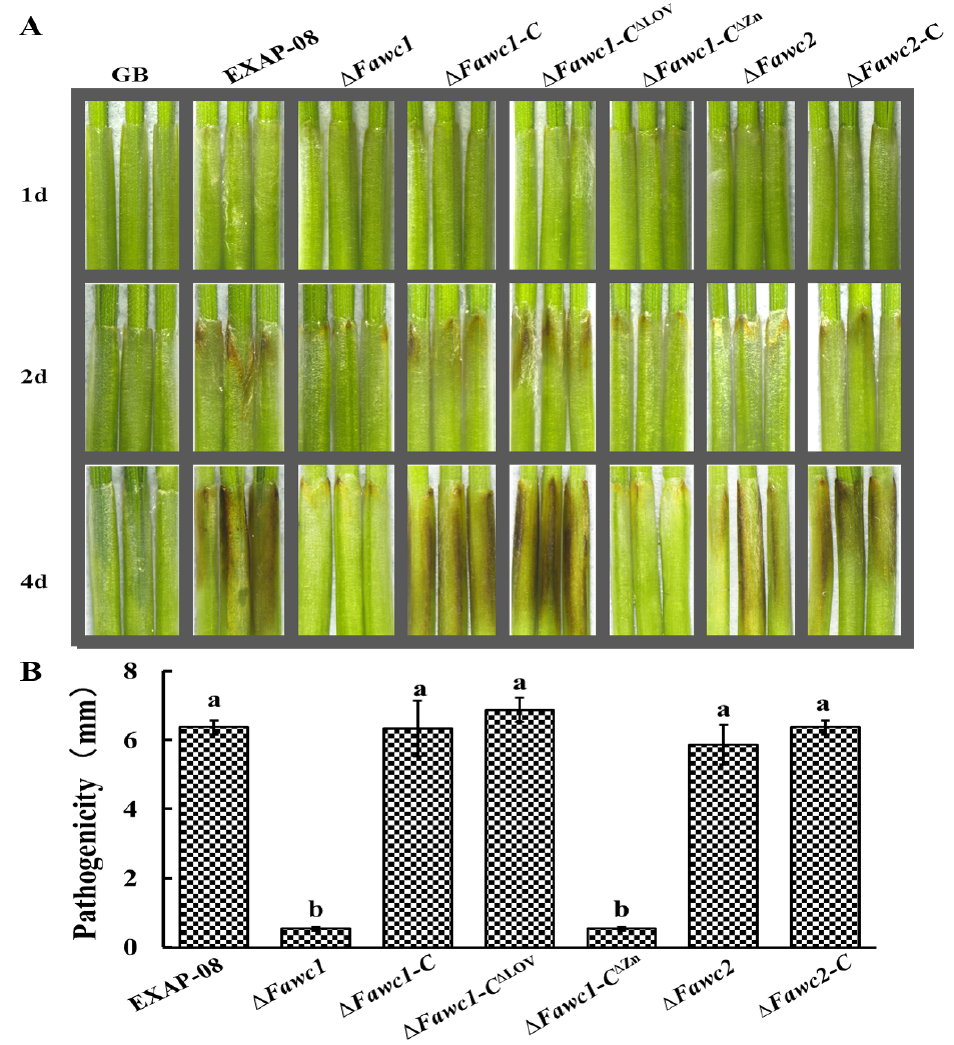
Figure 6. Virulence assay on wheat confirms that Fawc1 regulate the virulence of F. asiaticum in a light-independent manner. ( A ). Wheat coleoptiles were inoculated with 5 µL conidial suspensions and were kept humid inside a plastic box. Fungal strains for test include the wild-type EXAP-08, ∆ Fawc1 , ∆ Fawc1 - C , ∆ Fawc1-C ∆ LOV , ∆ Fawc1-C ∆ ZnF , ∆ Fawc2 , and ∆ Fawc2 - C . Photographs were taken at four days post inoculation. ( B ). Statistical analysis of lesion sizes caused by each fungal genotype. Di ff erent letters represent a significant di ff erence at p < 0.05. The bars present mean values ± SD ( n =